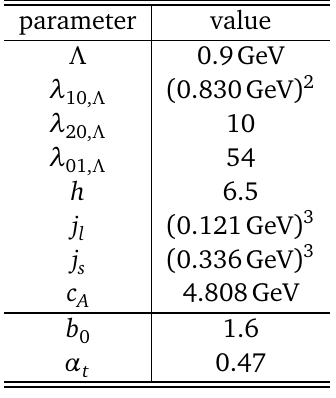
Table 1: Parameters for the initial effective action and the Polyakov loop potential. They are chosen such that we find in the vacuum at k = 0 for the pion mass m π = 138 = 495 MeV, for the σ -meson mass m = 463 MeV, for the MeV, for the kaon mass m σ K + m 2 = 1.218 GeV 2 , for the light current quark mass m = 302 MeV and for sum m 2 η η (cid:48) l = 113 MeV. The last two parameters belong the decay constants f π = 93 MeV and f K to the Polyakov loop potential and are fixed by the pressure of 2 + 1 flavor lattice QCD at vanishing chemical potentials, see App.